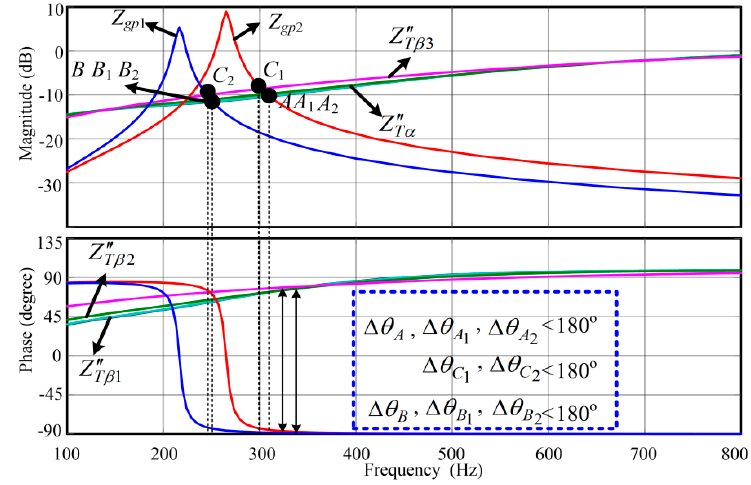
Figure 13. Bode plot of DFIG impedance and parallel compensated weak grid with low, medium, and high bandwidth Lead/Lag